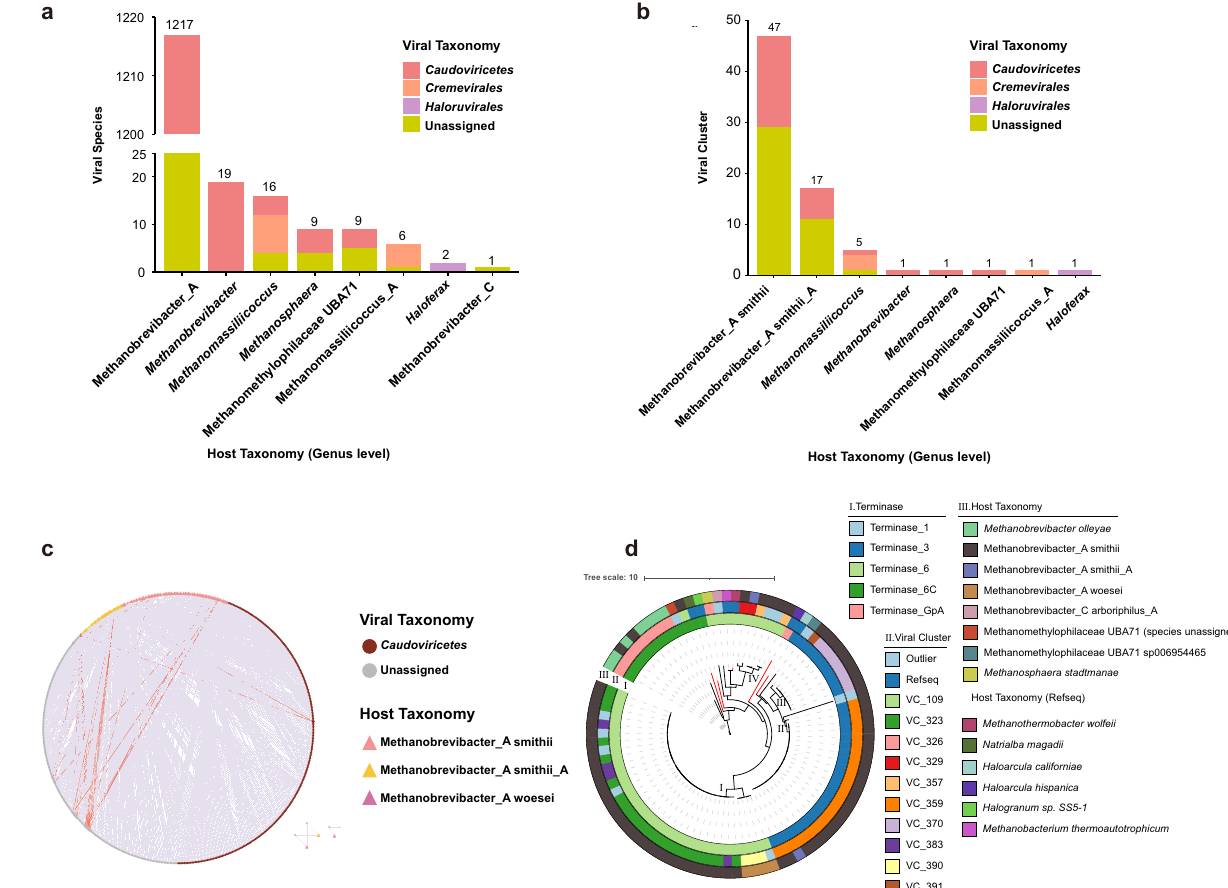
Fig.3|Archaealviralhostassignmentandhostrangedetermination.a Number of the HGAVD viral species per archaeal host genus. b Number of viral clusters (VCs) per host genus. c Network showing the connections of the HGAVD viruses andtheirhosts.HostassignmentwascarriedoutbyCRISPRspacermatching.Only the spacers recruited from the archaeal genomes of UHGG are included. The dots representing viruses are in brown, while the triangles representing the hosts of these viruses are in pink, yellow or purple. Only the connections representing